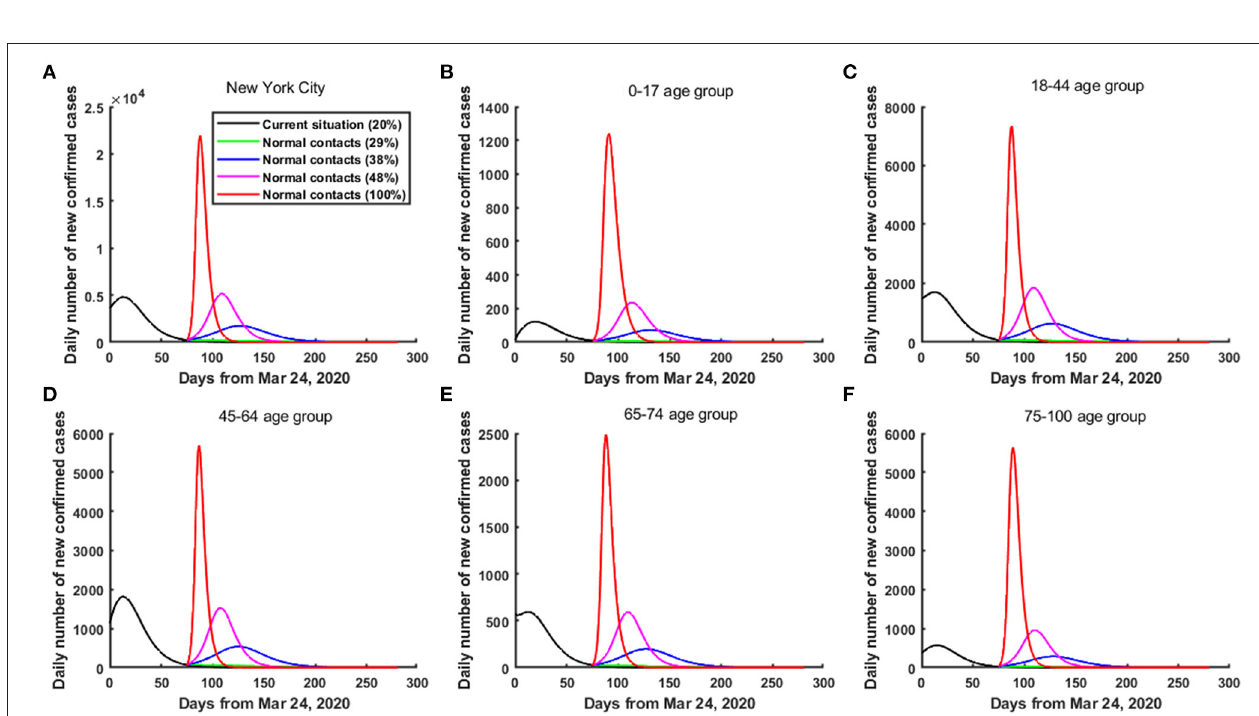
FIGURE 6 | The risk of a second wave of COVID-19 in NYC when only the 18-44 and 45-64 age groups were released from June 8, 2020. (A) In the whole population of NYC. (B) In the 0–17 age group. (C) In the 18–44 age group. (D) In the 45–64 age group. (E) In the 65–74 age group. (F) In the 75–100 age group.